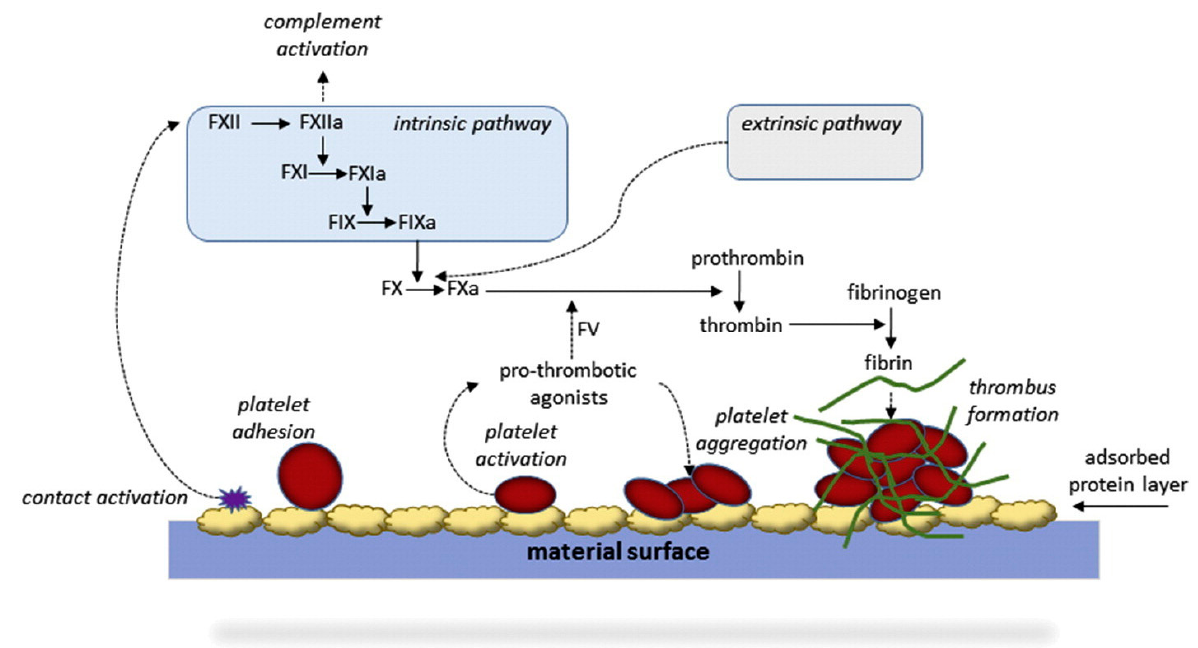
Figure 7. Simplified coagulation response by the contact activation of blood proteins. (Reprinted with permission from [62].).